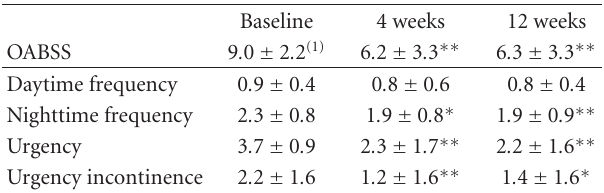
Table 1: Changes in overactive bladder symptom scores in 52 patients treated with propiverine